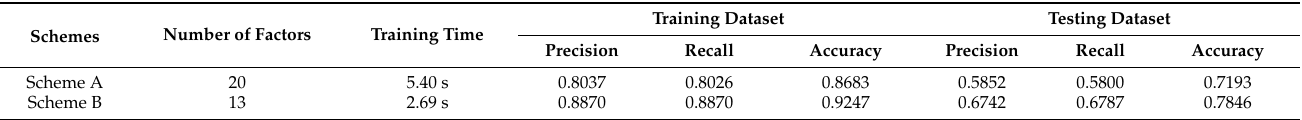
Table 6. A comparison of the two schemes for the site quality grade evaluation of Chinese